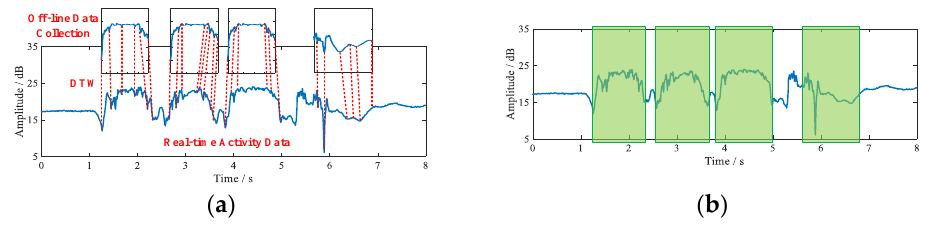
Figure 6. DTW algorithm process: ( a ) DTW matching process; ( b ) action matching results.